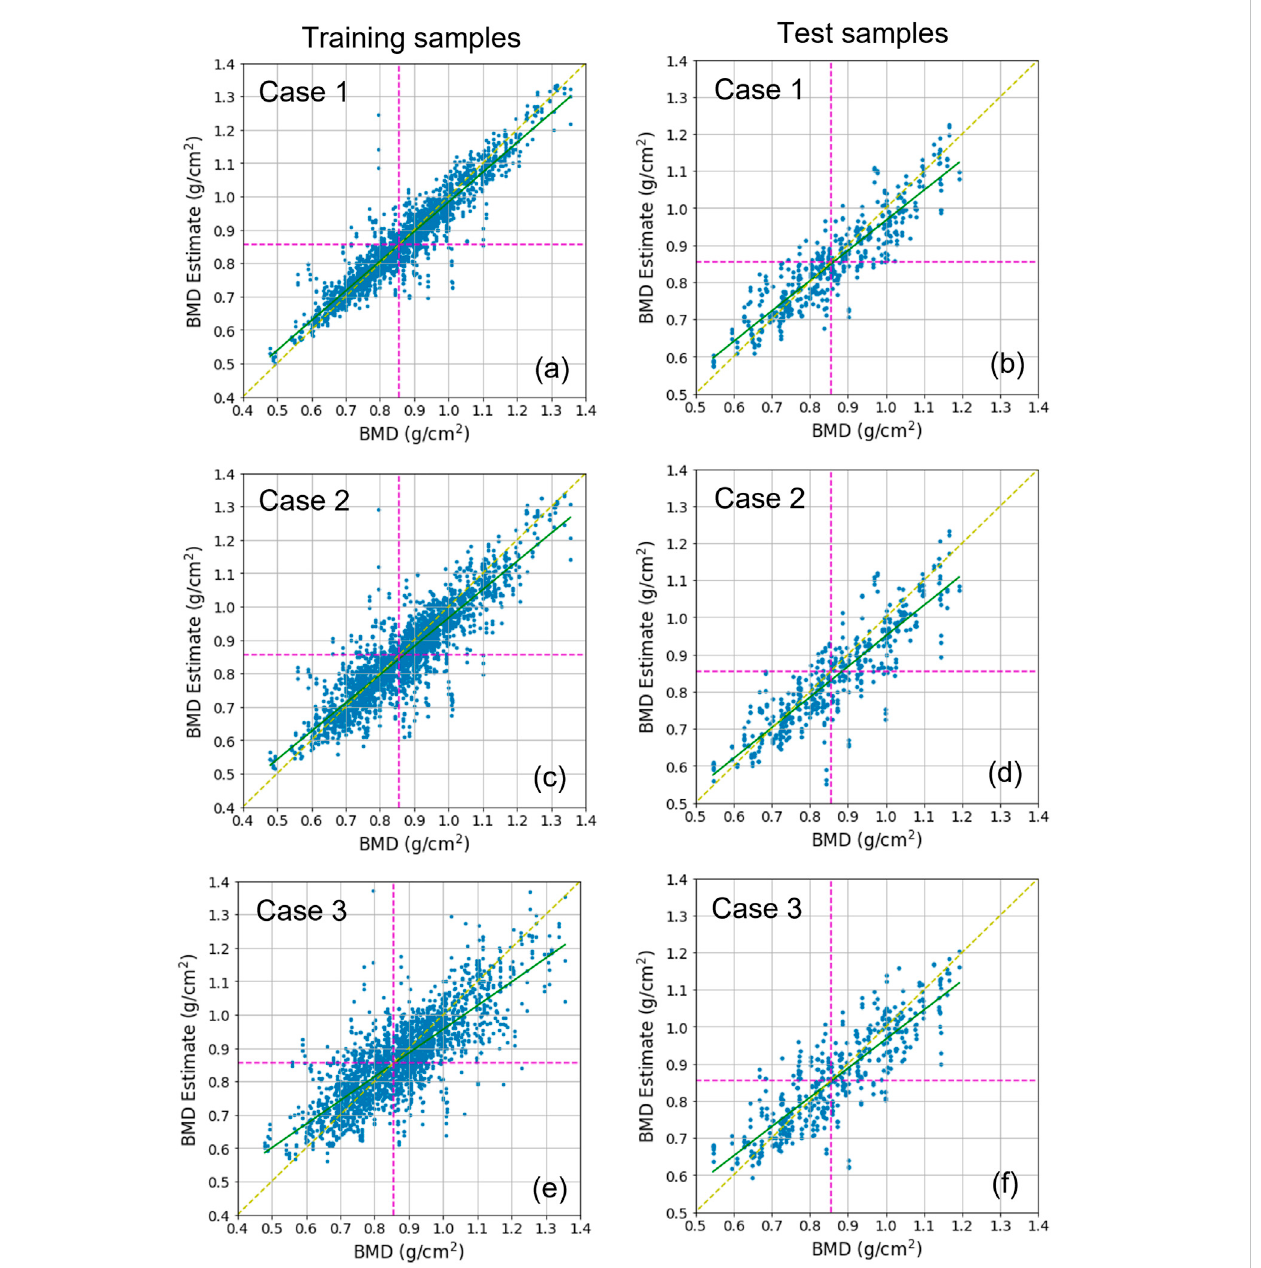
FIGURE 5 ScatterplotsdisplayingBMDestimatesoverreferences. (A,C,E) showthetrainingresults,and (B,D,F) showthetestresults. (A,B) showCase1results, (C,D) showCase2results,and (E,F) showCase3results.Ineveryplot,thegreenlineisthelineofthebest fi tforsamples.Theyellowdotteddiagonallinedenotesthe ideal reference line for checking the skewness of the fi tted line. The dotted horizontal and vertical line denotes the decision boundary for classifying bone diseases. The boundary value corresponds to .856 g/cm 2 as a BMD and − 1.0 as a